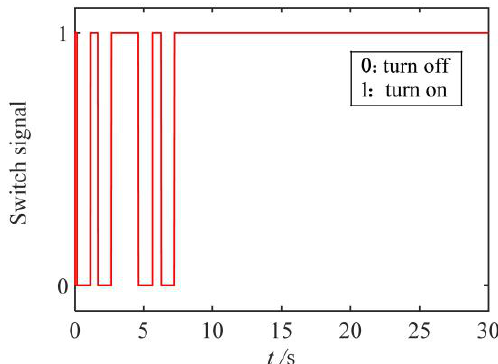
F =120 N m, F =10 N m   ). Figure 8. Switch signal of motor ( Figure 8. Switch signal of motor (F C1 = 120 N · m, F O1 = 10 N · C1 O1